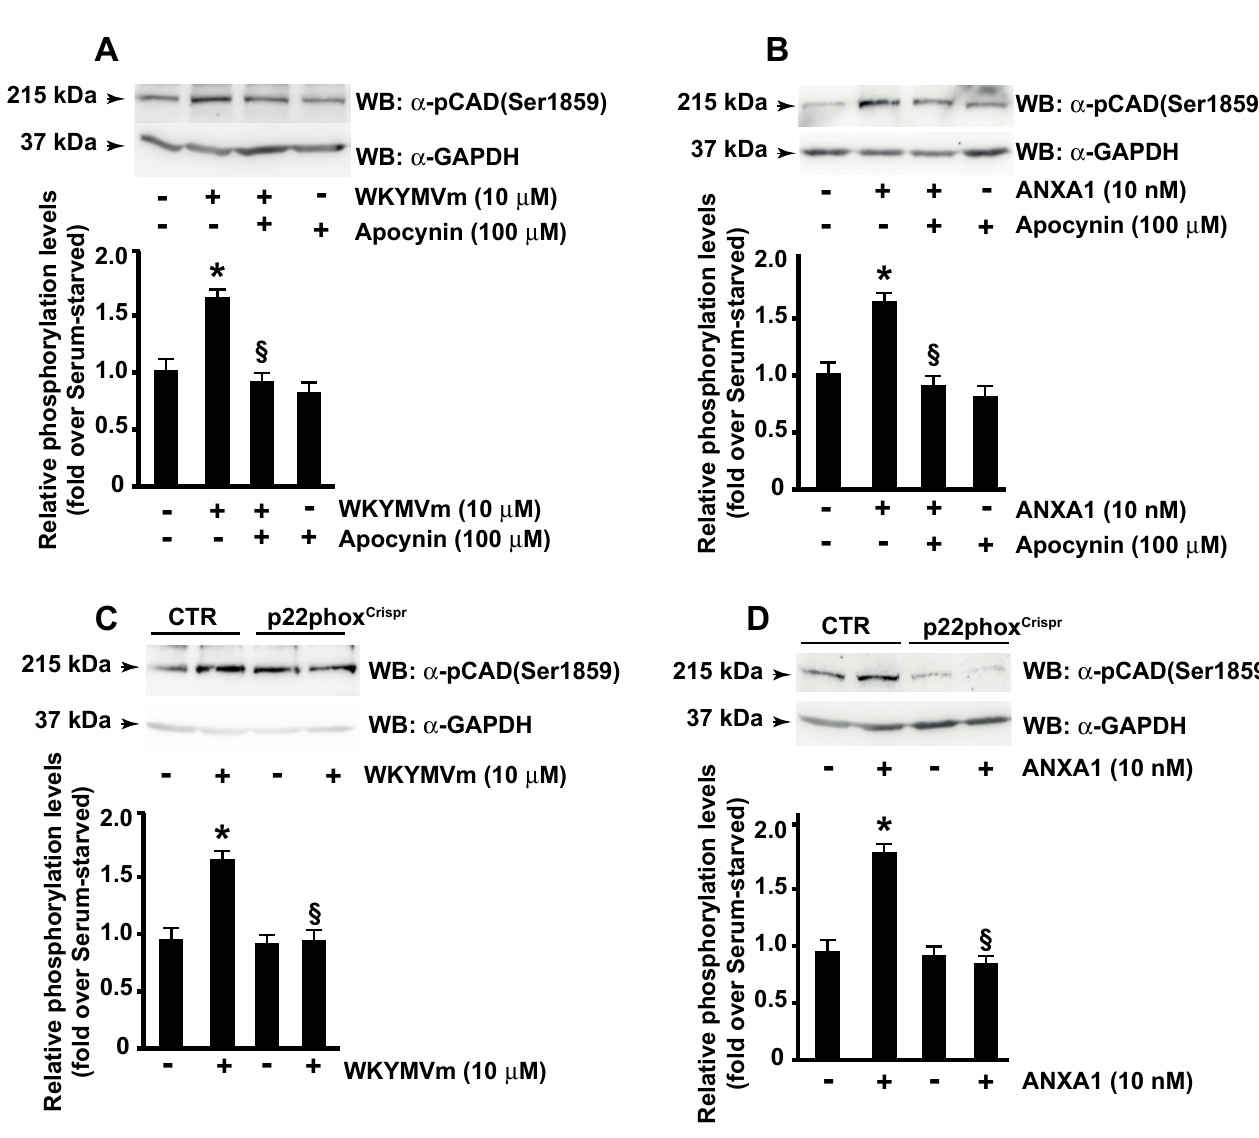
Figure 6. FPR2-mediated CAD phosphorylation requires NADPH oxidase activation. Serum- deprived CaLu-6 cells were preincubated with apocynin before the stimulation with WKYMVm (Panel A ) or ANXA1 (Panel B ). CaLu-6-control Crispr/Cas9 (CTR) and p22phox Crispr/Cas9 CaLu-6 (p22phox Crispr ) cells were serum-starved for 24 h and then stimulated with WKYMVm (Panel C ) or ANXA1 (Panel D ). Sixty micrograms of whole lysates were resolved on 10% SDS-PAGE and incubated with an anti-phospho-CAD (Ser1859) ( α -p-CAD (Ser1859)) antibody. An anti-GAPDH ( α -GAPDH) antibody was used as a control for protein loading. Data are representative of three independent experiments. * p < 0.05 compared to unstimulated cells. § p < 0.05 compared to stimulated cells.